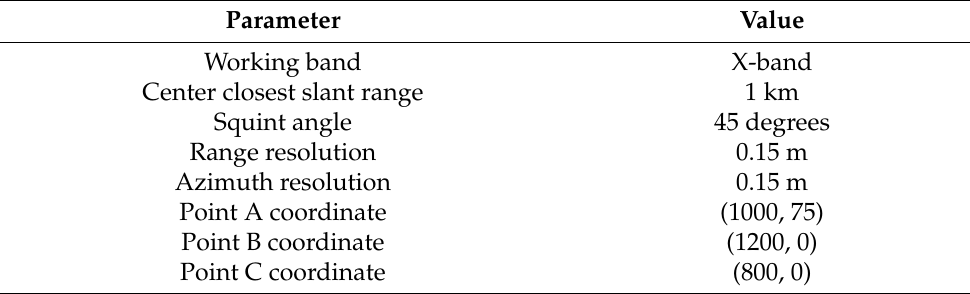
Table 1. Simulation parameters.